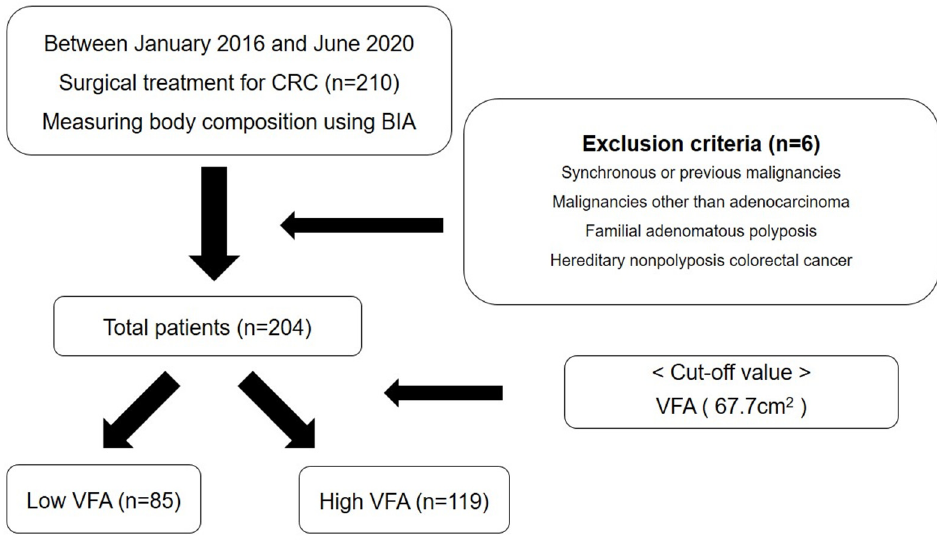
Figure 1. Flow chart of the exclusion